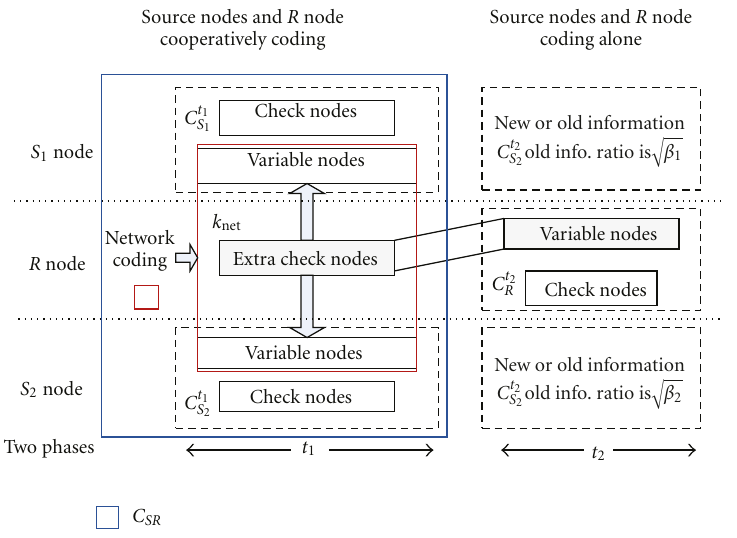
Figure 3: The cooperative strategy based on parity-check network